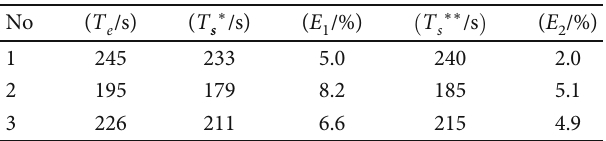
Table 3: Accuracy of simulation.